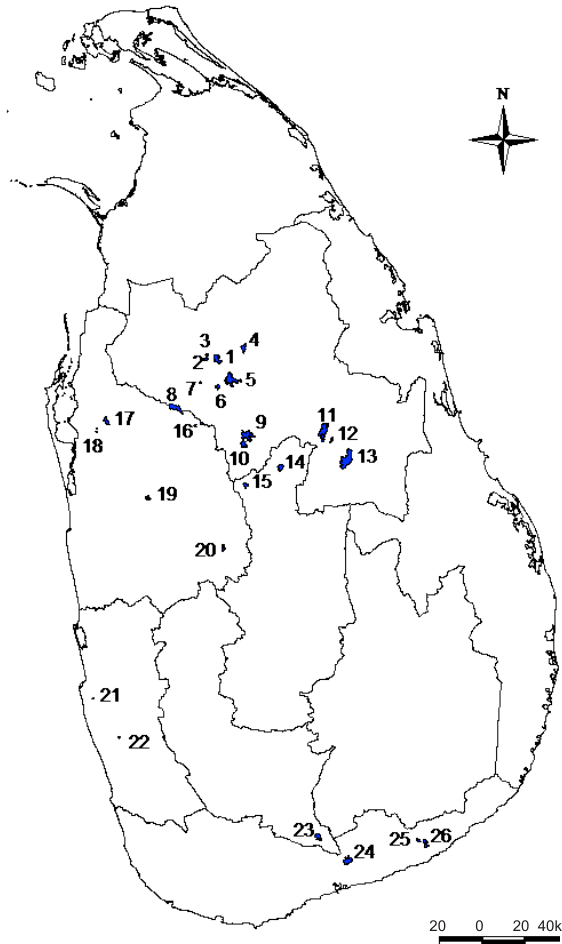
Figure 1. Reservoirs of Sri Lanka surveyed for the occurrence of tiger